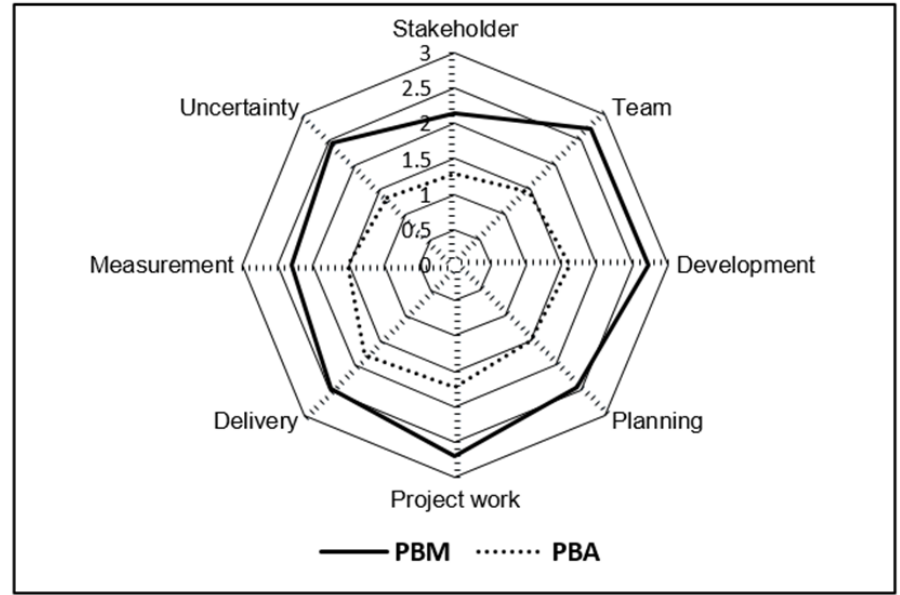
Figure 1. Assessment result of BATM model.